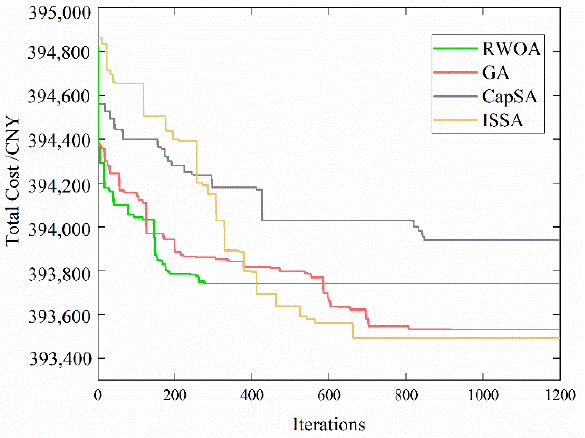
Figure 8. Comparison of average values of the four algorithms for 19 instances.